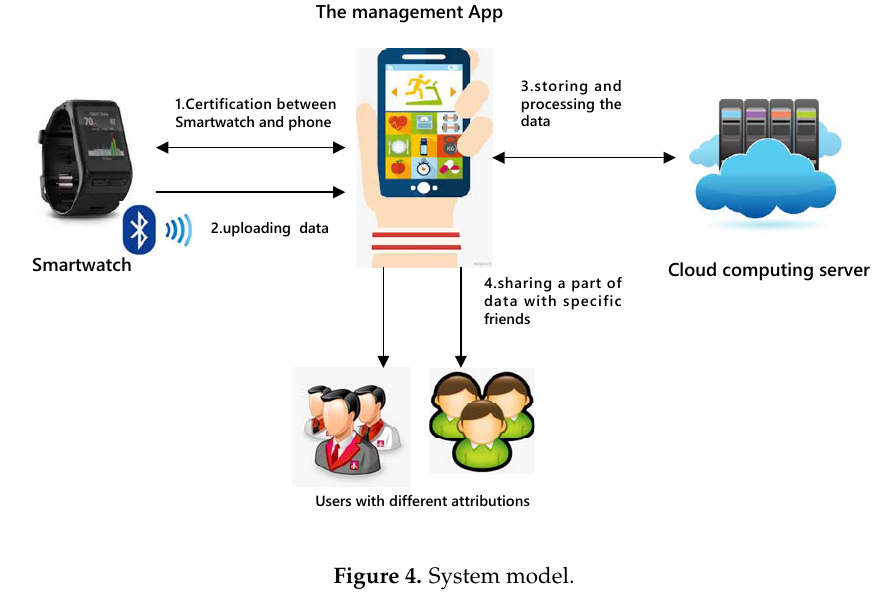
Figure 4. System